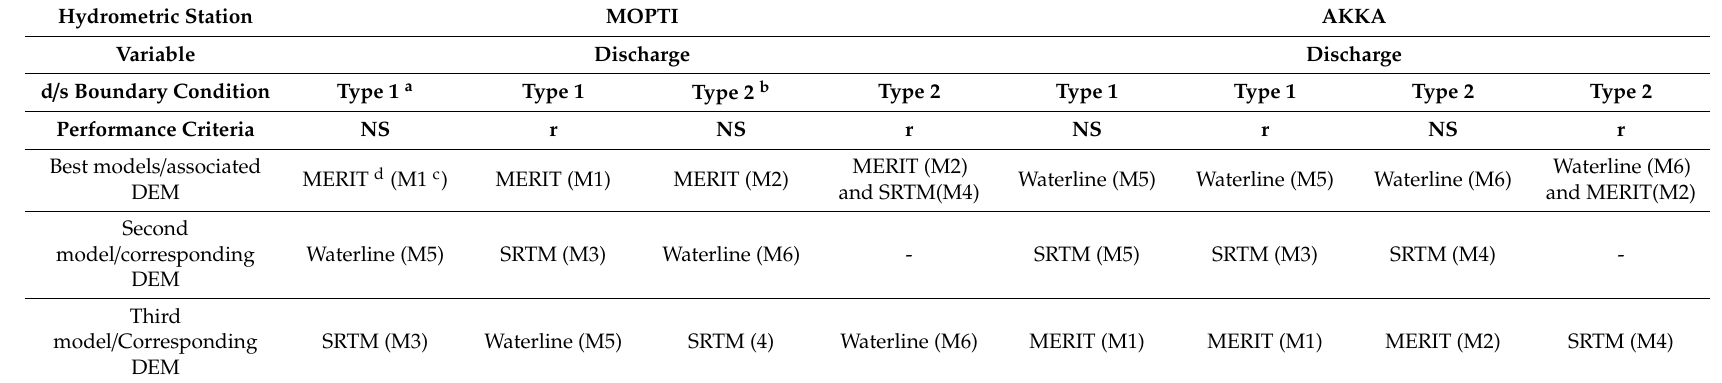
Table 7. Model ranking based on performance (NS and r) for discharge at Mopti and Akka.